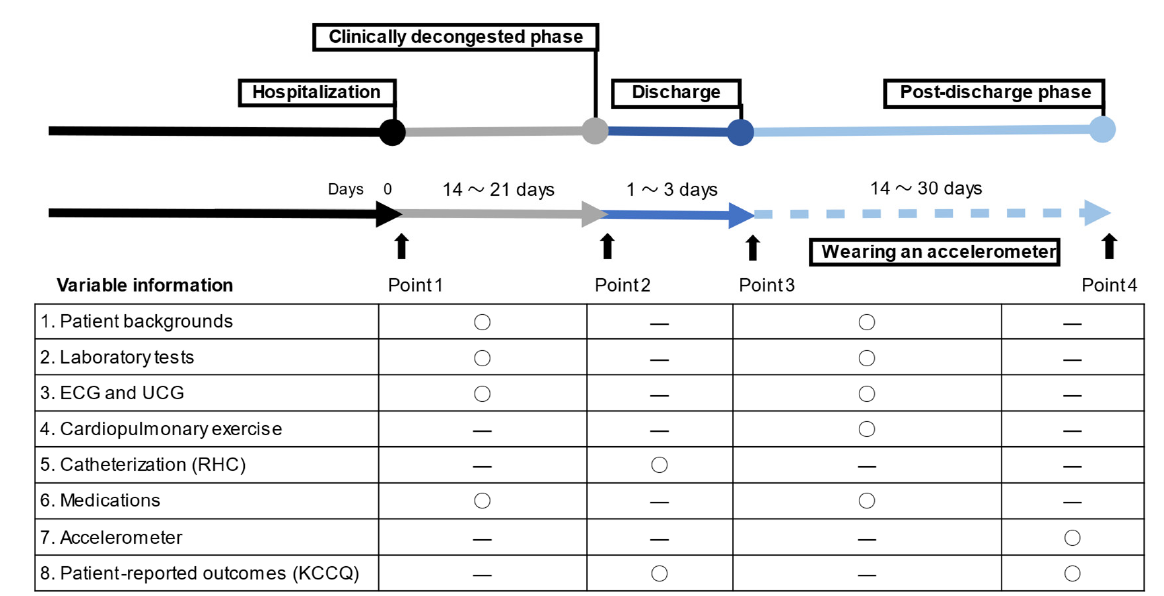
Figure 1. A summary of measured variables. Circles mean the correction point for each item. ECG = electrocardiogram; UCG = ultrasound cardiogram; RHC = right heart catheterization; KCCQ = Kansas City Cardiomyopathy Questionnaire.